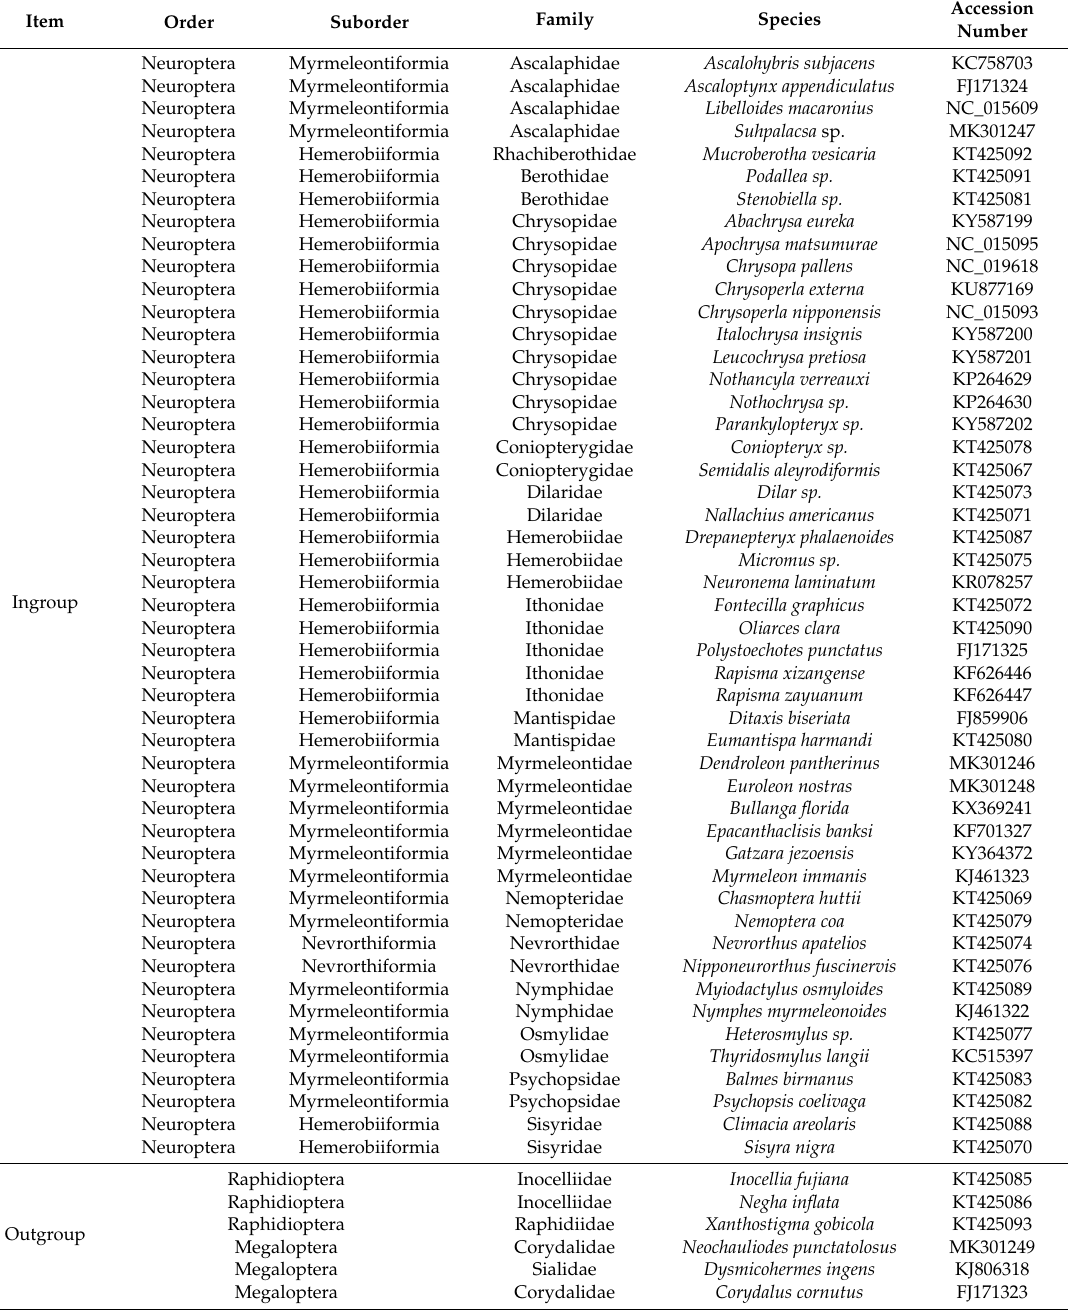
Table 1. Listing of taxa included in this study. Included is the detailed taxonomic status of each species used in the phylogenetic analyses and the GenBank accession number for each